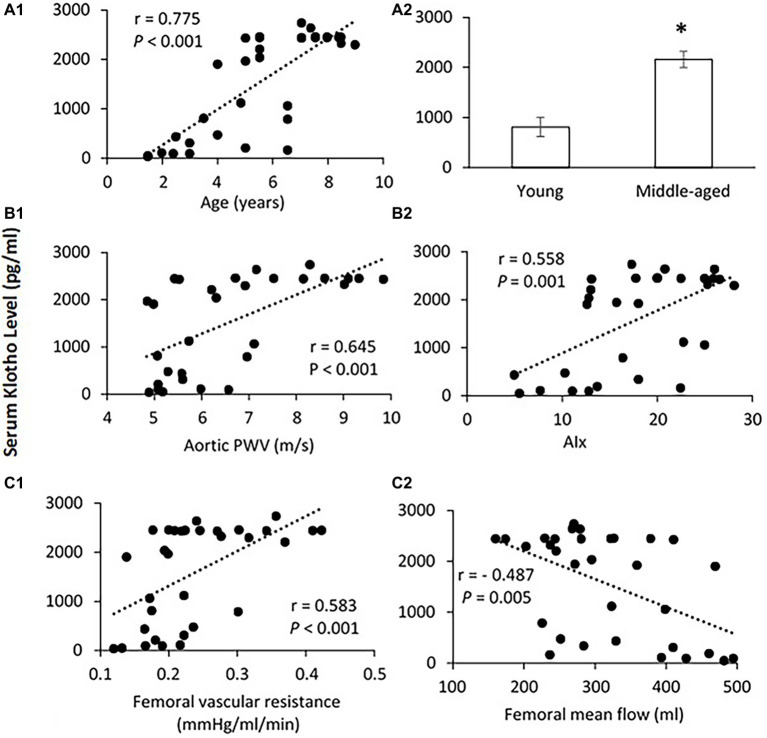
(A) Correlation of serum Klotho level with age (A1) and the mean levels of serum Klotho (A2) in young and middle-aged pigs. Data corresponds to means ± SEM. p < 0.05, when compared to young group. (B) Correlations of serum Klotho levels with aortic PWV (B1) and AIx (B2). (C) Correlations of serum Klotho levels with femoral vascular resistance (C1) and mean flow (C2). The Spearman’s correlation test was conducted, and data are expressed as correlation coefficients and significance levels (r; p).